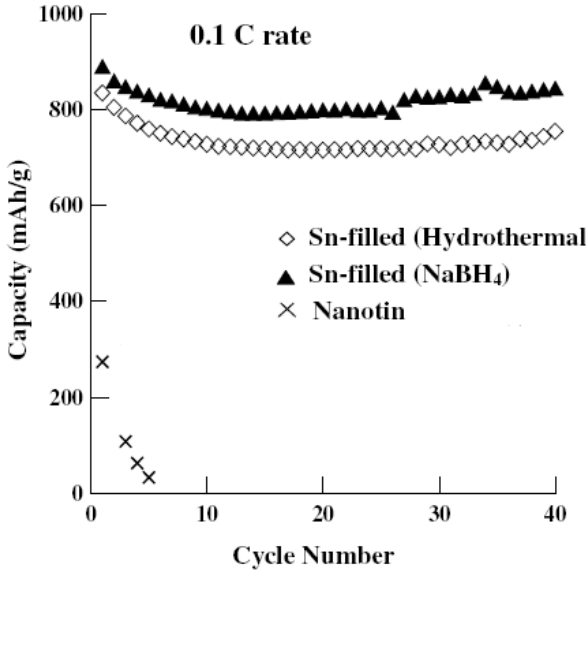
Figure 8. Cycling performances of nanotin and tin-filled carbon nanotubes. Adapted